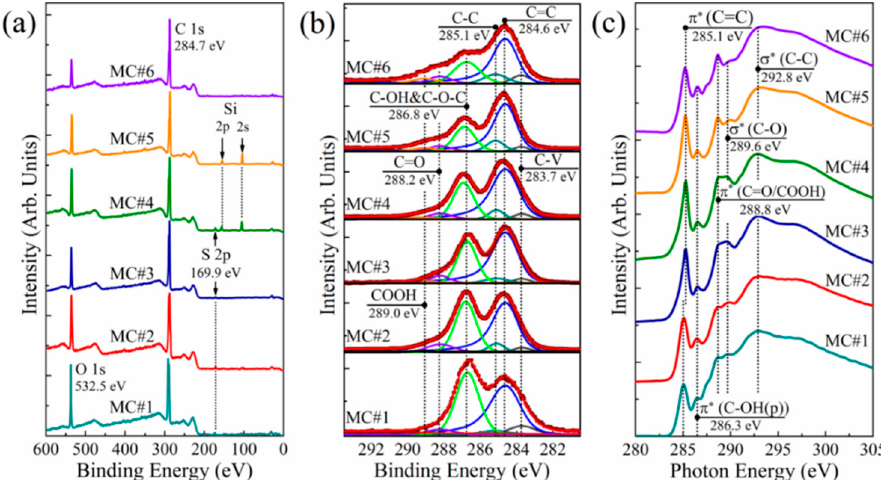
Figure 2. ( a ) Survey and ( b ) C 1s X-ray photoelectron spectra of the MC#1–MC#6 films; ( c ) C K- edge X-ray absorption spectra of the MC#1–MC#6 samples. The spectra are vertically offset for